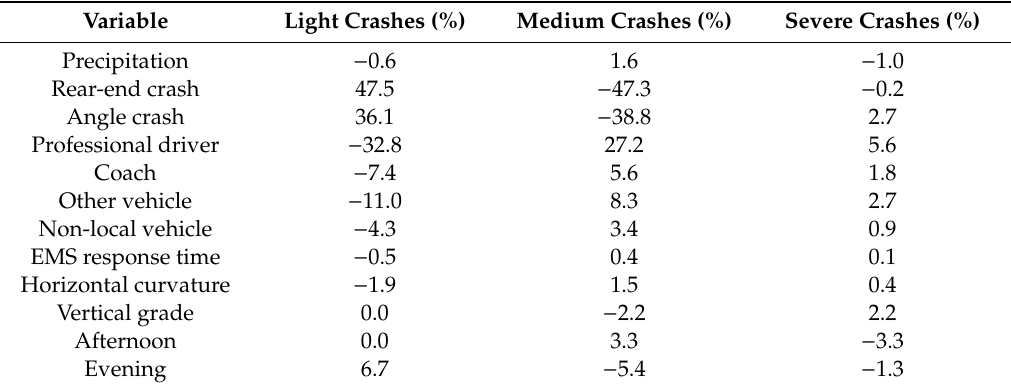
Table 4. Marginal e ff ects of significant variables in the spatial generalized ordered logit model.